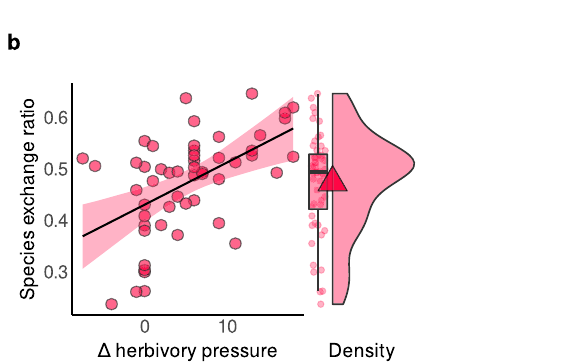
credible interval. Dashed lines represent statistically unclear relationships. Fre- quency distributions (density, boxplot and points) of the respective response variables are displayed alongside. Boxplots bound the interquartile range (IQR) divided by the median and whiskers extend up to a maximum of 1.5 × IQR beyond the box. Triangles indicate the mean. Horizontal lines at zero indicate no change. Source data are provided as a Source Data fi